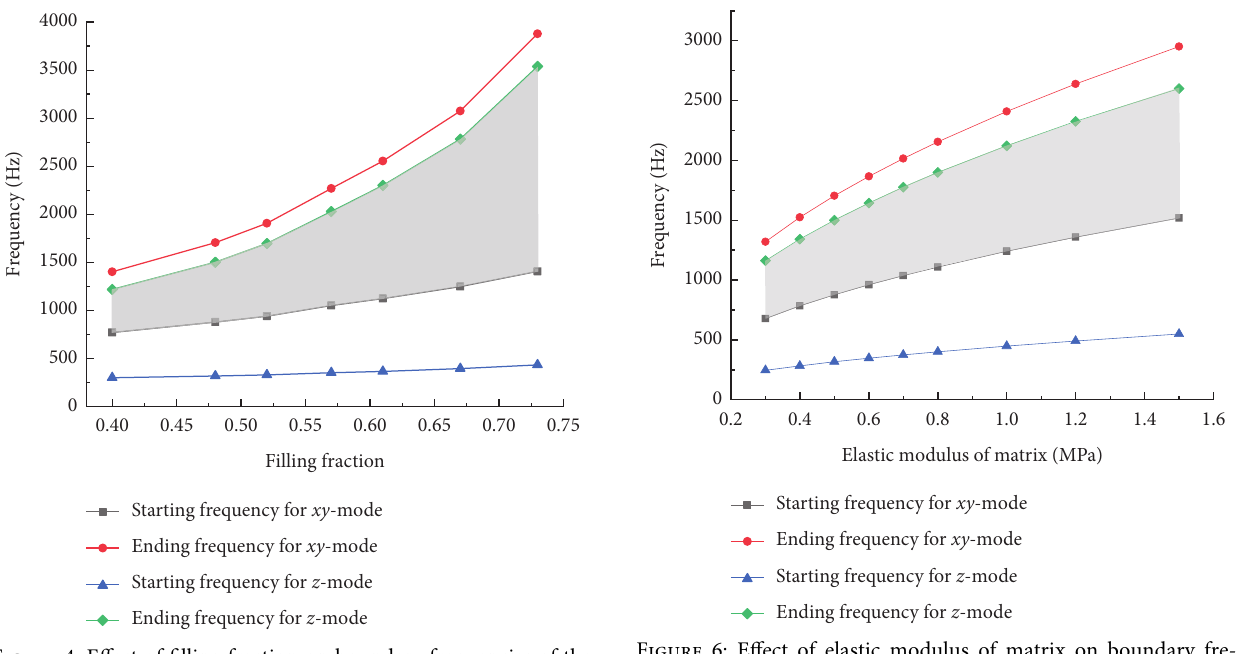
Figure 4: Effect of filling fraction on boundary frequencies of the 1st complete band gaps.